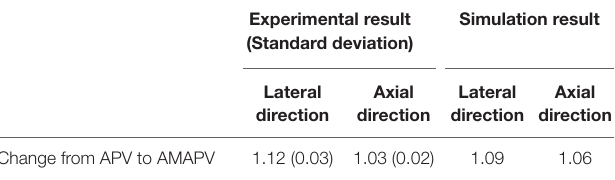
TABLE 2 | Effect of applying the eight-ring mask to modulate the amplitude distribution of the APV excitation